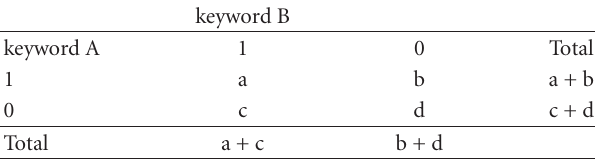
Figure 6: Comparison of cluster partition from incomplete “Kokoro” text data derived with Dice’s coe ffi cient imputed by three TIBAs. were preprocessed using “Chasen” morphological analysis Table 1: 2 × 2 contingency table for text system software (http://chasen.naist.jp/hiki/ChaSen/), which